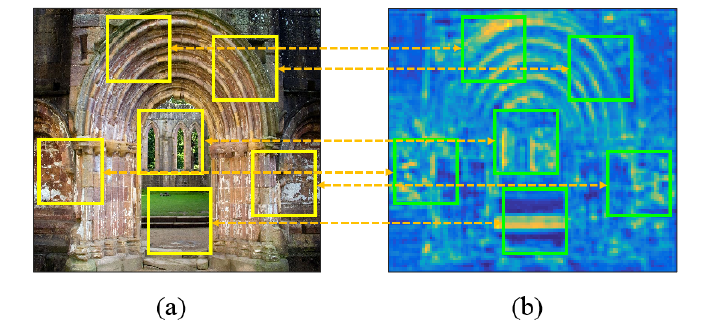
Figure 2. ( a ) The input image; and ( b ) the CSM in 4th convolutional layer. In order to intuitively view the corresponding relationship between the input image and the CSM, we resize the CSM to the size of the input